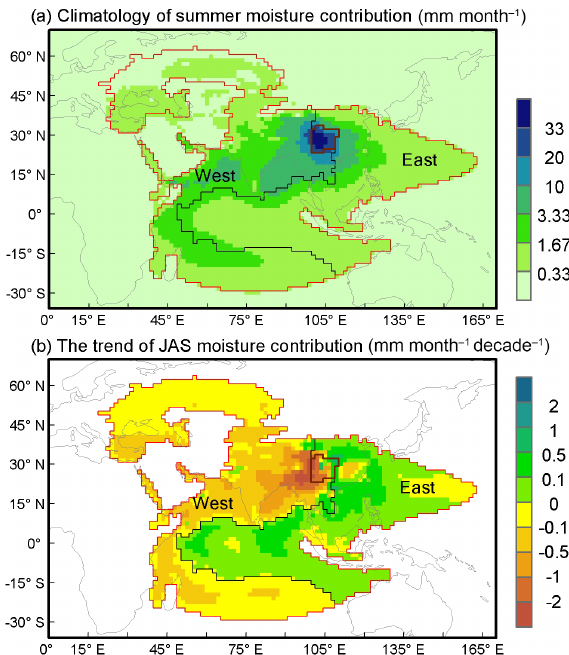
Figure 10. (a) Climatology of the JAS moisture contribution to the SWC precipitation from 1979 to 2013 with ERA-I E and P . (b) The trend of the JAS moisture contribution from 1979 to 2013 with ERA-I E and P . The red line and east–west division are the same as in Fig.